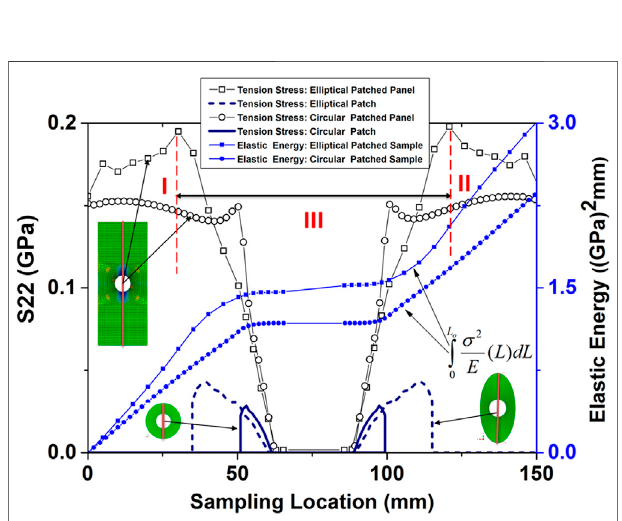
FIGURE 17 | Tensile stress (S22) along the longitudinal axes of the patched samples and patches.